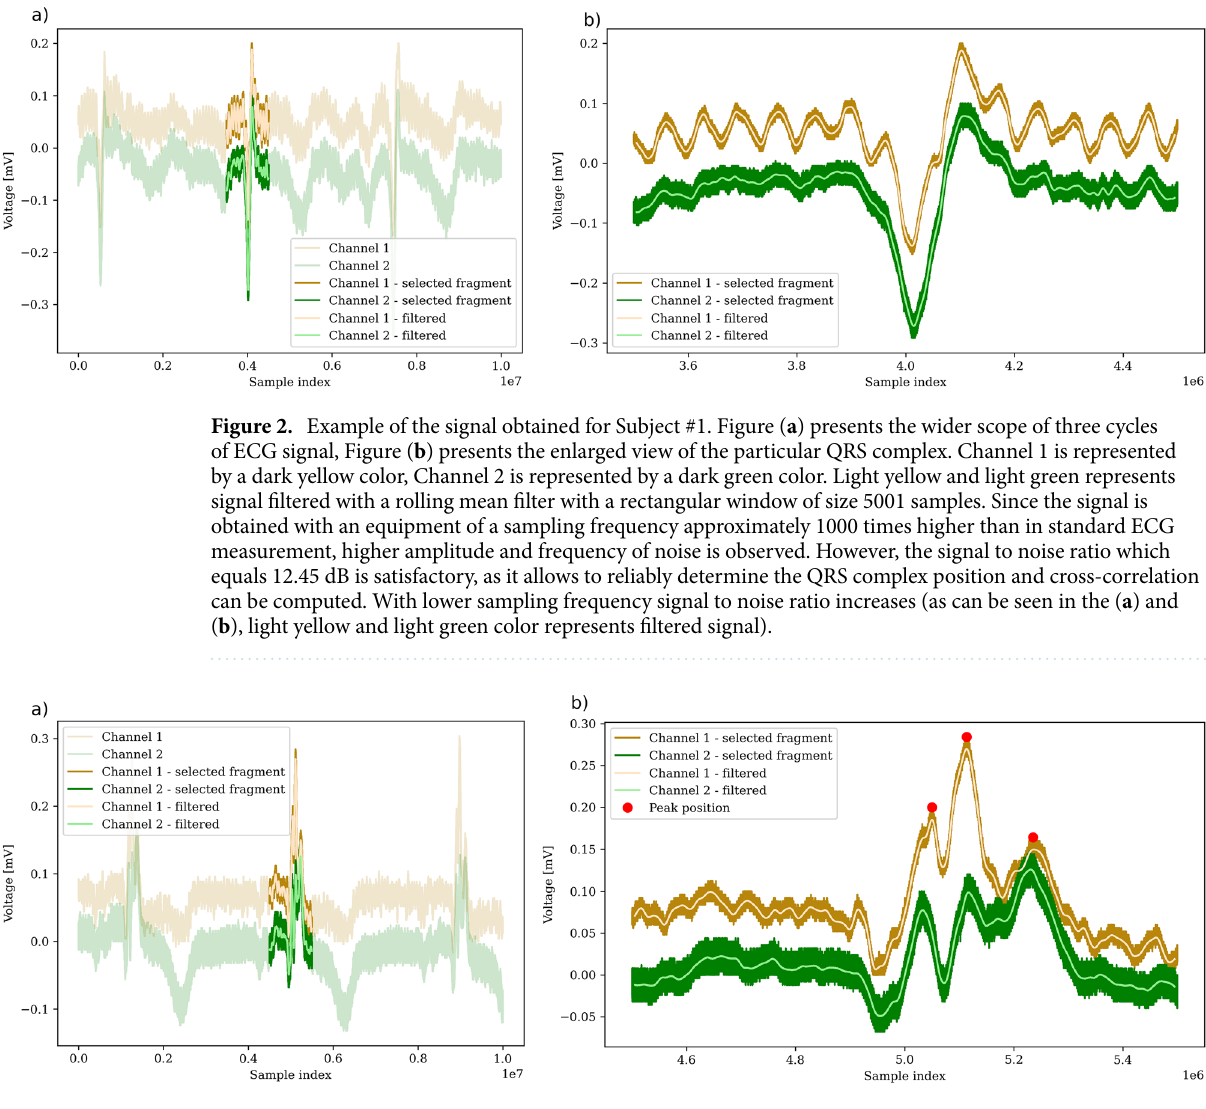
Figure 3. Example of the signal obtained for Subject #3. Figure ( a ) presents the wider scope of three cycles of ECG signal, Figure ( b ) presents the enlarged view of the particular QRS complex. The differences in signal morphology can be observed between Subject #1 (Fig. 2b) and Subject #3, mainly in the QRS area - for Subject #1, Q wave amplitude (downward deflection) is much bigger than for Subject #3. For Subject #3, additional low- frequency noise was discovered mainly within the QRS area. For subject #1 (the youngest participant), this noise had the smallest amplitude and did impact the uncertainty to a lesser extent. The potential causes of this noise are described in the Discussion section.